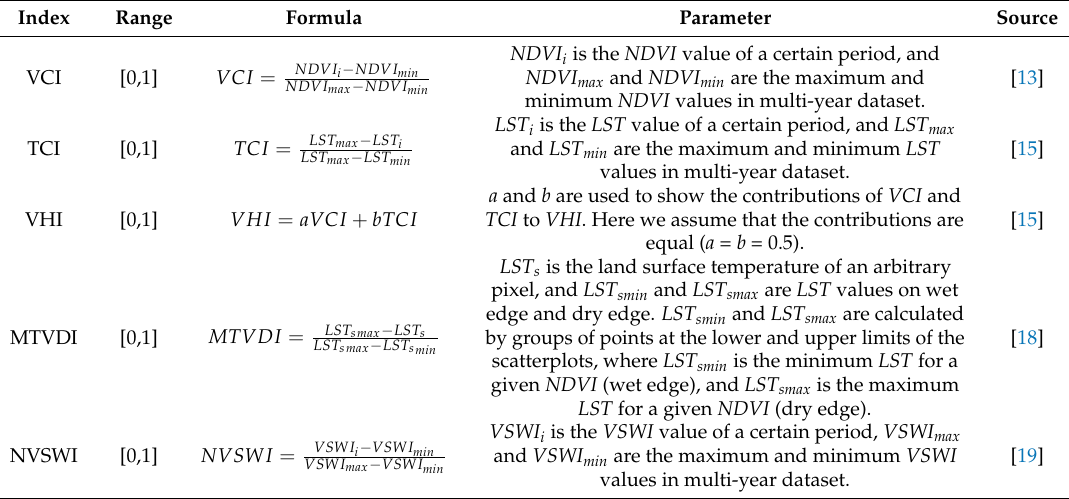
Table 1. Descriptions of remotely sensed drought indices (RSDIs).